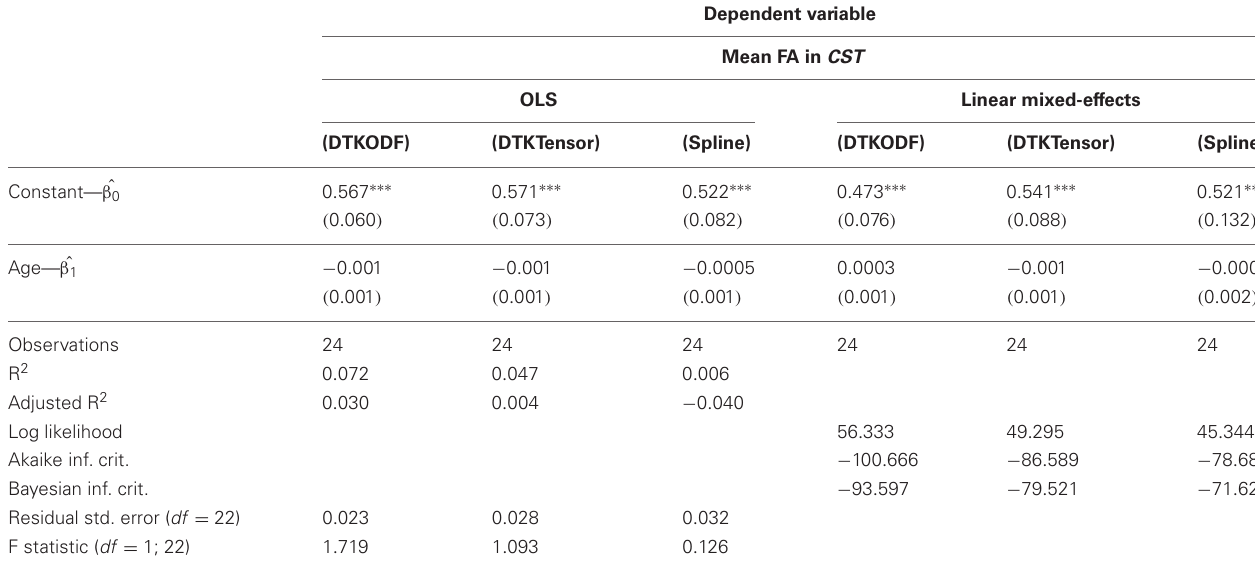
Table 2 | CST —Ordinary least squares lm() and linear mixed-model regression lmer()